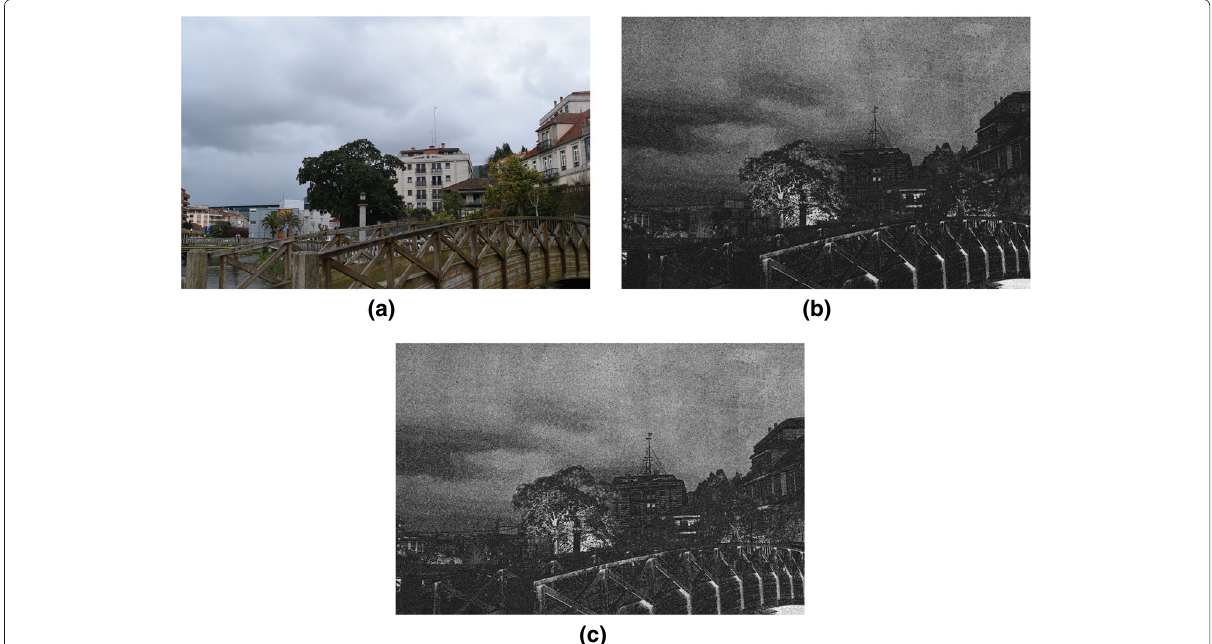
Fig. 5 (a) Image from the database taken with the Nikon D3300 camera; (b) residual after planting the PRNU from Fig. 3 bottom-left, where traces of the car in Fig. 3 top-right are perfectly visible; (c) residual as in (b) where all images used for extracting the PRNU and the target image are JPEG-compressed with QF=92; the traces of the car are still